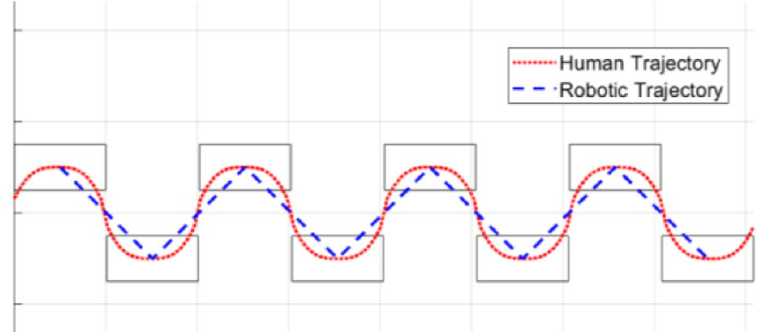
Figure 1. Difference between a typical bipedal robotic ZMP trajectory and a human ZMP trajectory